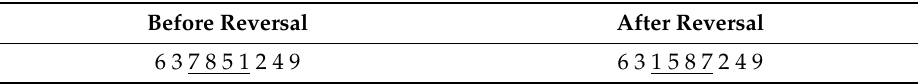
Table 4. Example of the reversal operation.